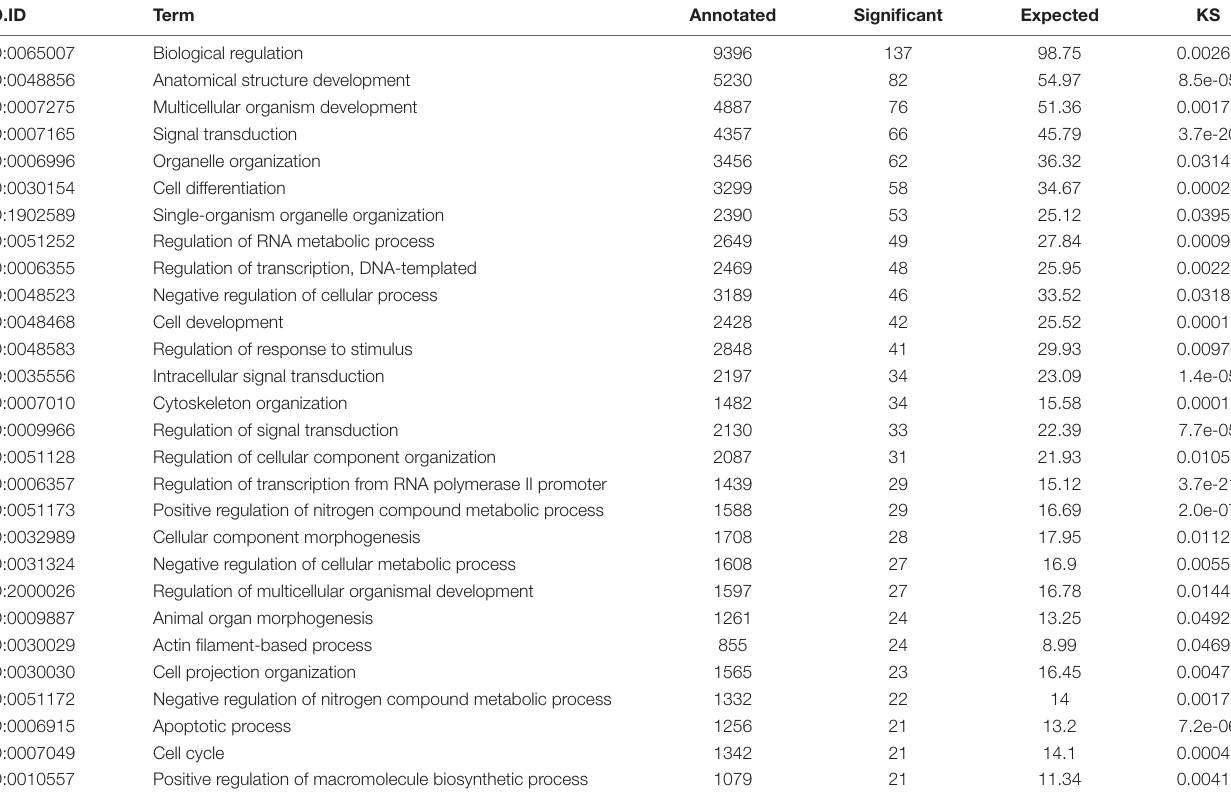
TABLE 4 | Significant GO enrichment analysis of different expression unigenes in spleen of hybrid grouper fed fresh fish oil (R group) and highly oxidized fish oil (H group). GO.ID